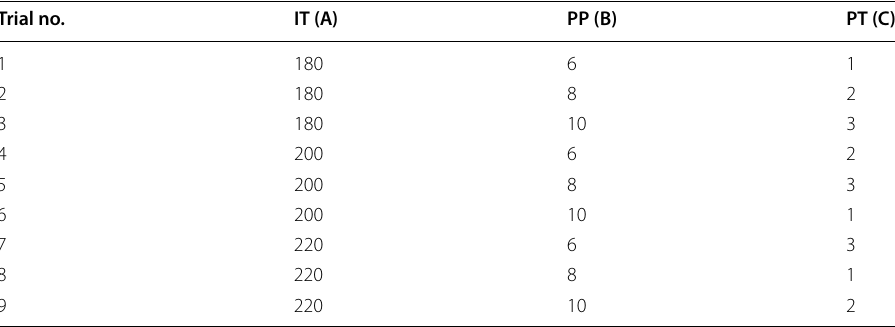
Table 2 Experimental design Trial